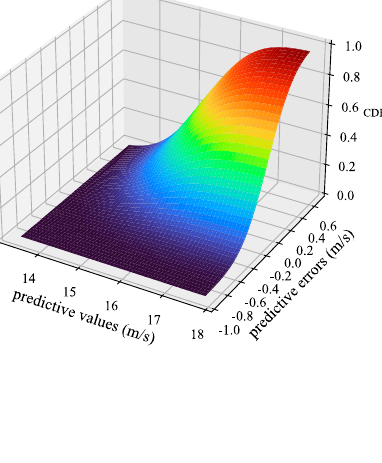
Figure 5. Joint PDF and PDF of Datasets 1–3.